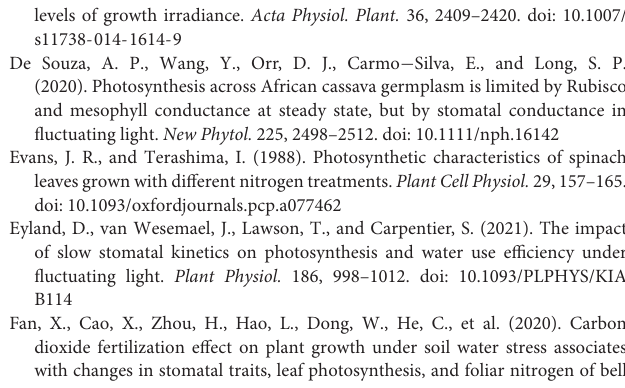
Supplementary Figure 1 | Relationships between t 90AN (A) , t 90gs (B) , and the initial g s prior to light change. HN, MN, and LN represent tomato plants grown under high, medium, and low N concentrations, respectively. Supplementary Figure 2 | Response of intrinsic water use efficiency (iWUE) after transition from 50 to 1,500 µ mol photons m − 2 s − 1 . Values are means ± SE ( n = 5). HN, MN, and LN represent tomato plants grown under high, medium, and low N concentrations,